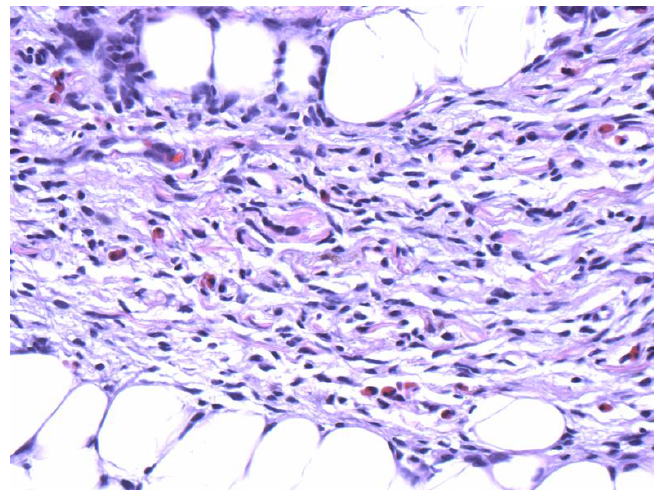
Figure 3. Numerous eosinophils are scattered within the spindle cell proliferation (40×).